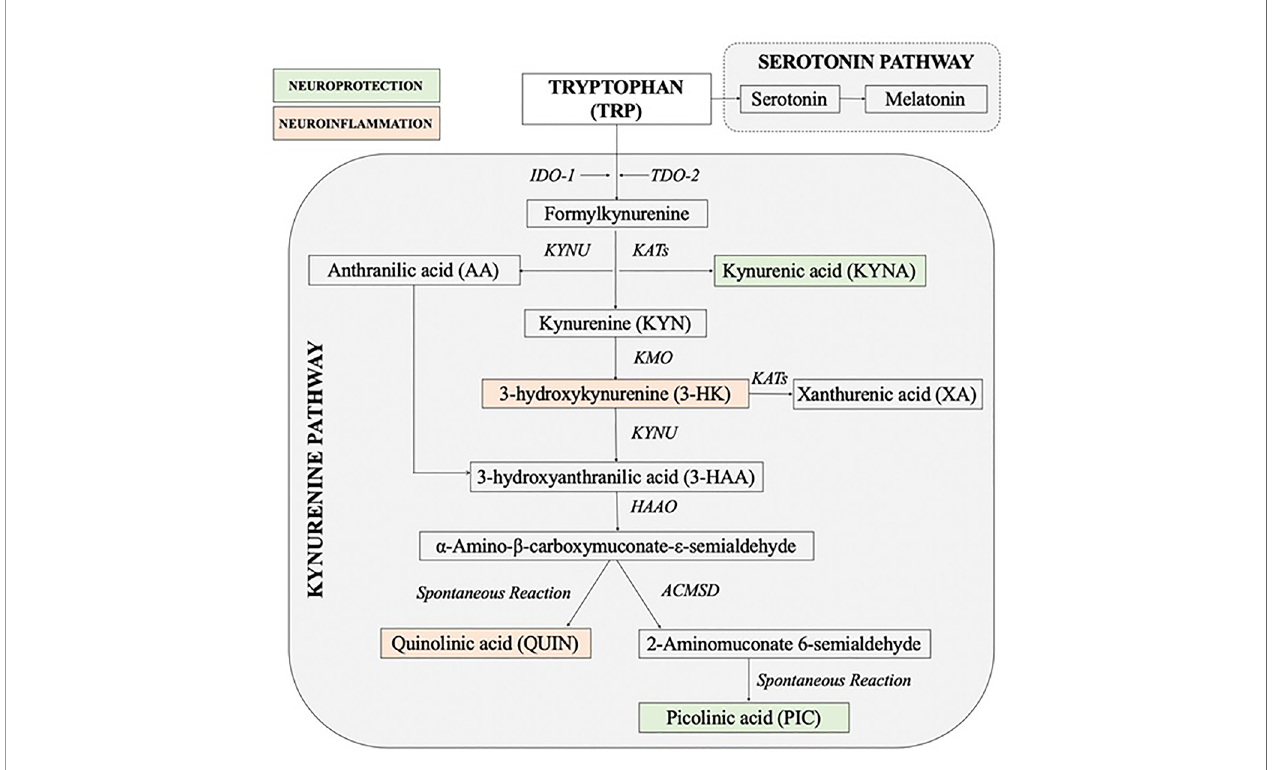
FIGURE 1 | Simpli fi ed diagram of the kynurenine pathway [Adapted and modi fi ed from (26)]. 3-HAAO, 3-hydroxyanthranilic acid dioxygenase; ACMSD, aminocarboxymuconate semialdehyde decarboxylase; IDO, indoleamine 2, 3-dioxygenase; KATs, kynurenine aminotransferases; KMO, kynurenine 3-monooxygenase; KYNU, kynureninase; TDO, tryptophan 2,